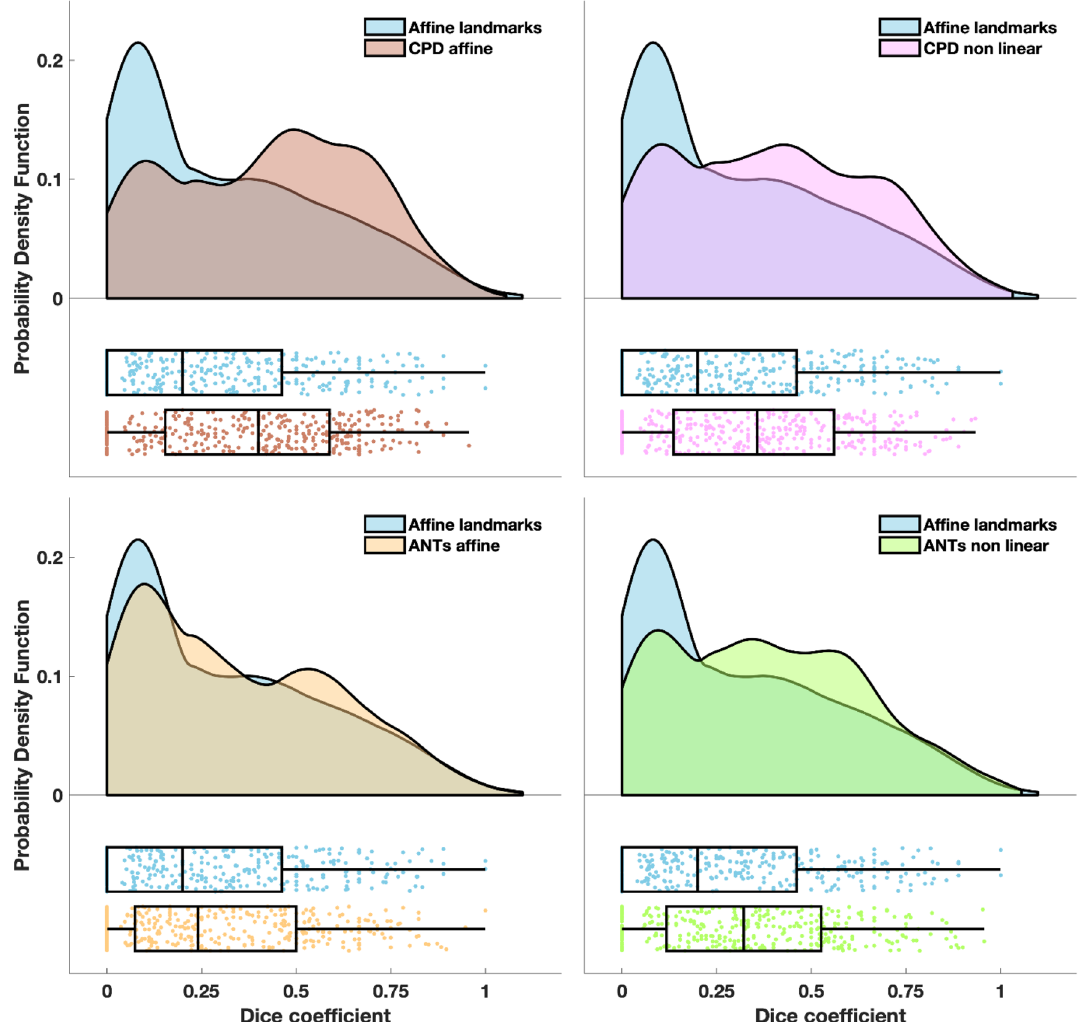
Figure 7. Dice coefficient between the benchmarks of the fluence distribution and registered fluence distributions. The probability density function of the Dice coefficients obtained with CPD affine (top left panel), CPD non linear (top right panel), ANTs affine (bottom left panel) and ANTs non linear (bottom right panel) are superimposed to probability density function of the localization errors obtained with the affine transformation based on landmarks. In the lower part of each panel, the same data are presented as a box plot. Left and right edges of the box indicate the 25th and 75th percentile, whereas the central mark indicates the median. The whiskers extend to the most extreme data value not considered an outlier. Each dot represents a sensor of a participant. Probability density functions were estimated with the kernel density estimation method and graphs were generated as described in Allen et al. 65 .